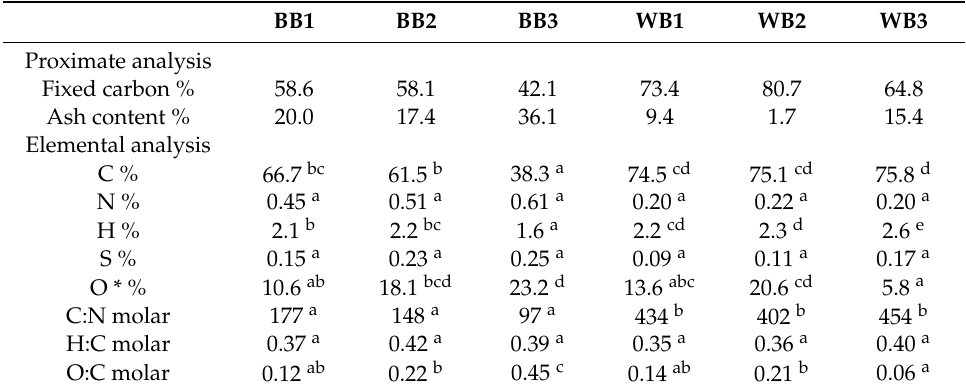
Table 4. Proximate and elemental analysis of bamboo biochar (BB), pinewood biochar (WB) and replicates (1, 2 and 3).